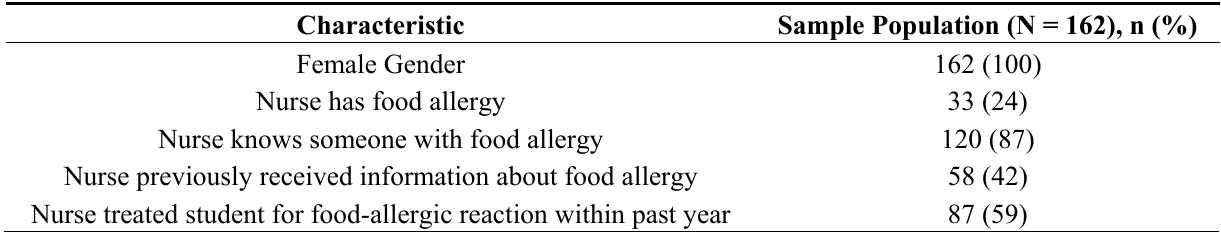
Table 1. Demographic characteristics of school nurses.